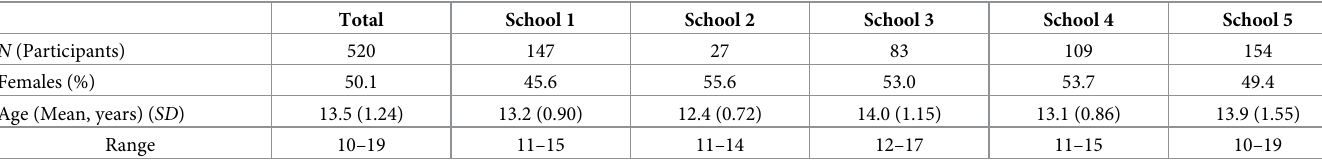
Table 1. Sample characteristics by